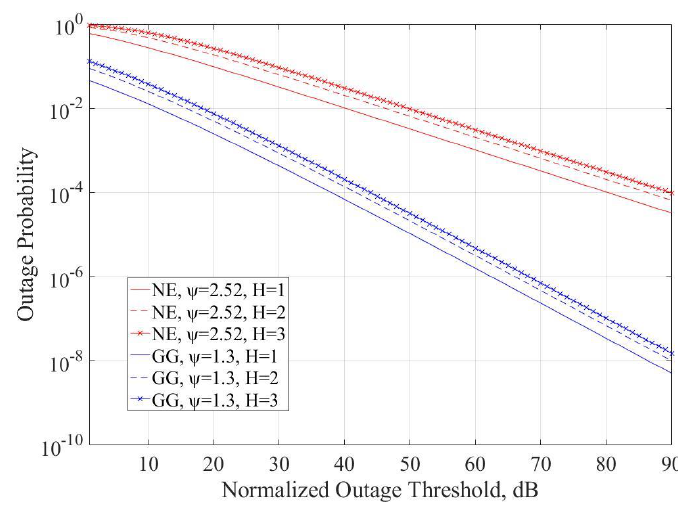
Computation 2019 , 7 , 34 Figure 1. OP versus the normalized outage threshold. Figure 1. OP versus the normalized outage threshold.